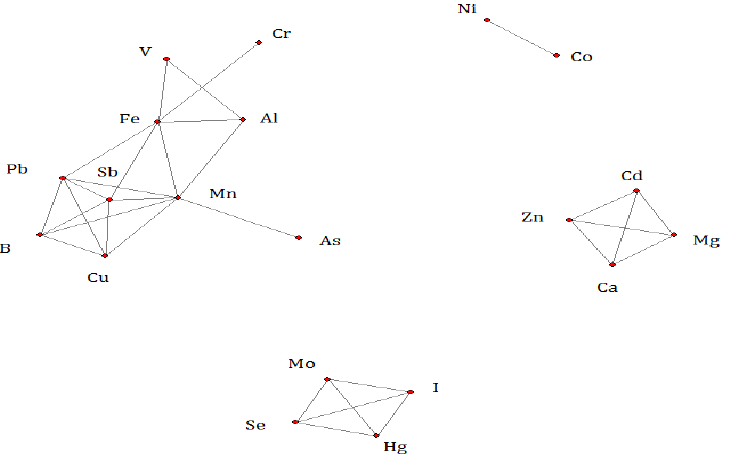
Figure 2. A Gaussian network solution of trace elements (on the natural log scale of the concentra ‐ tion